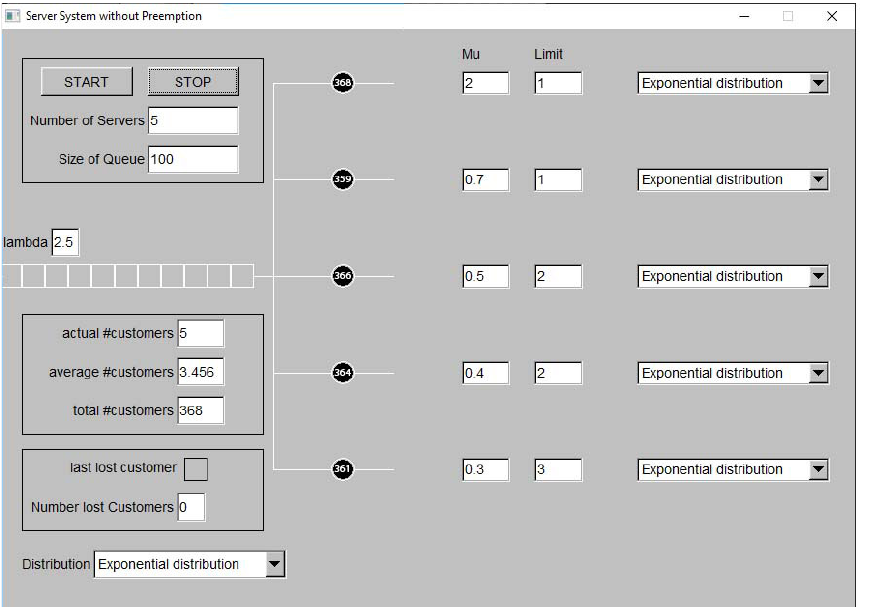
Figure 10. Simulation of the heterogeneous queueing system without